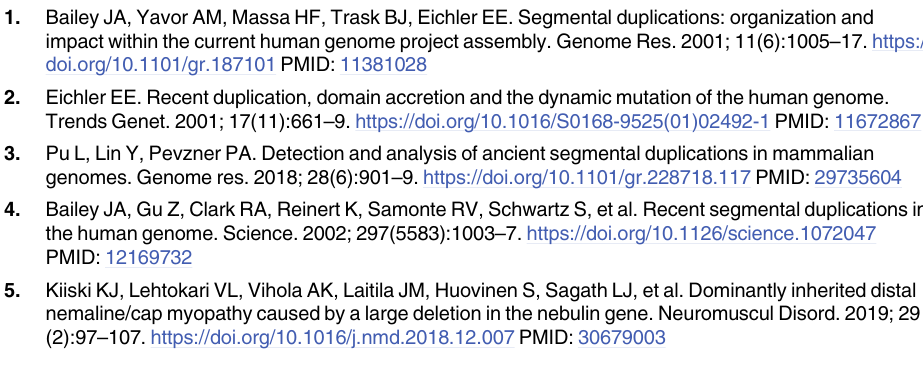
S12 Table. NEB TRI exon IV filtered data. S13 Table. NEB TRI exon VIII filtered data. S1 Fig. Example 2D droplet intensity plots of NEB TRI exon IV and exon VIII assays on patient DNA and no-template controls as extracted from the Quantasoft Analysis Pro soft-